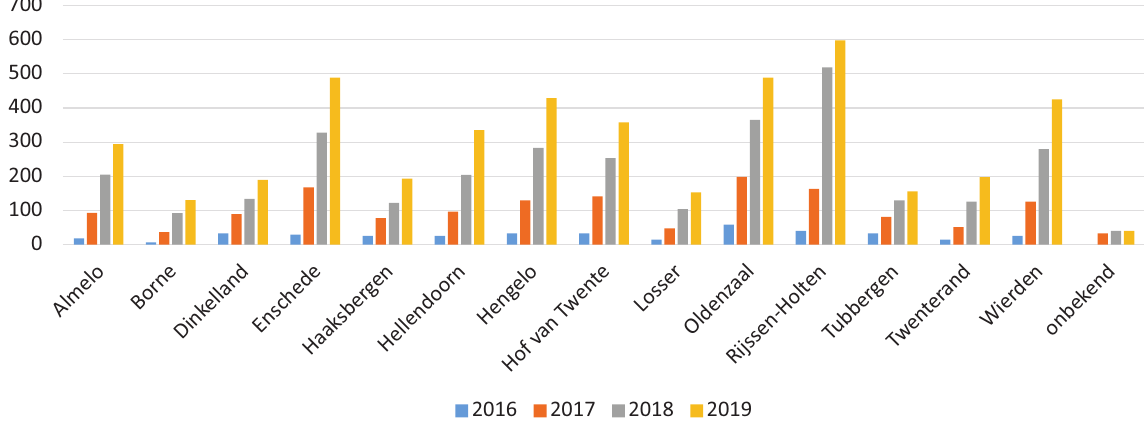
Figure 2. Cumulative amount of advice sessions booked by households in various municipalities of the Twente region. Source: DTT